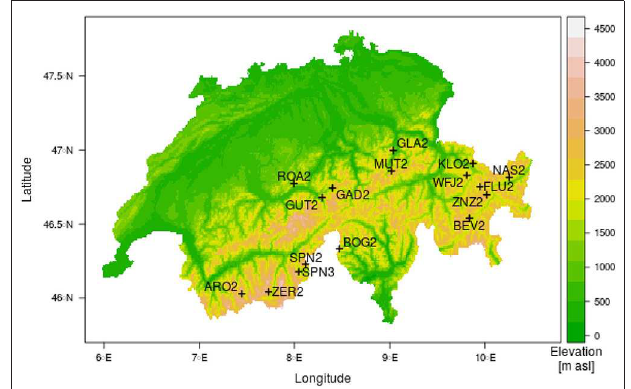
FIGURE 1 | Location and elevation of the 16 stations used in the